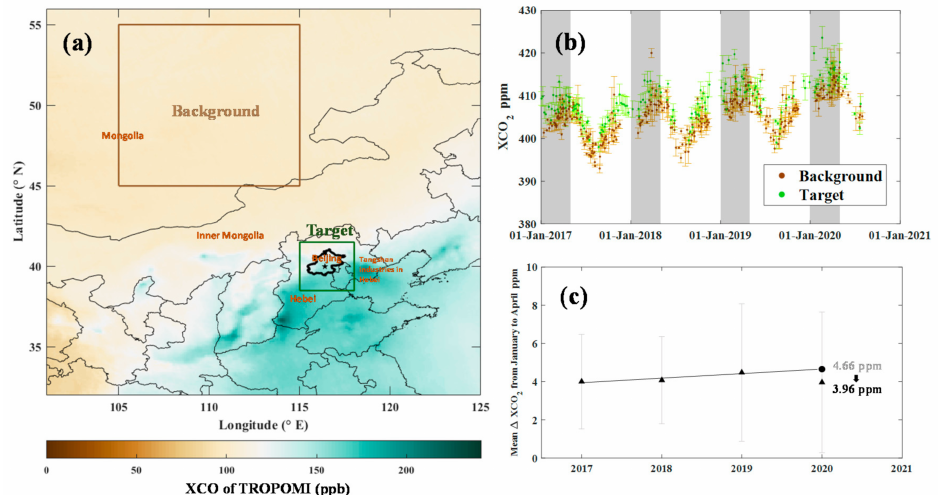
Figure 1. ( a ) Map of TROPOMI XCO averaged from January to April 2019. The region (38.5–41.5 ◦ N, 115–118 ◦ E) was selected as the target area (green shading) and the region (45–55 ◦ N, 105–115 ◦ E) was selected as the background region (brown shading). Beijing is outlined by the bold black line and the EM27/SUN Fourier transform spectrometer observation site in urban Beijing is marked by the black star. ( b ) Daily error bars and mean values of XCO 2 measured by GOSAT from 2017 to 2020 over the target (green) and background (brown) regions. The Error bar presents the standard deviation for each day. The first quarter of each year is indicated by gray shading. ( c ) Error bars and mean values of XCO 2 for the first quarter of each year. The estimated trend from 2017 to 2019 is plotted as the black line. The estimated increase in XCO 2 ( ∆ XCO 2 ) in 2020 is shown with black circle and the observed ∆ XCO 2 with black triangle. The Error bar presents the standard deviation for each year.